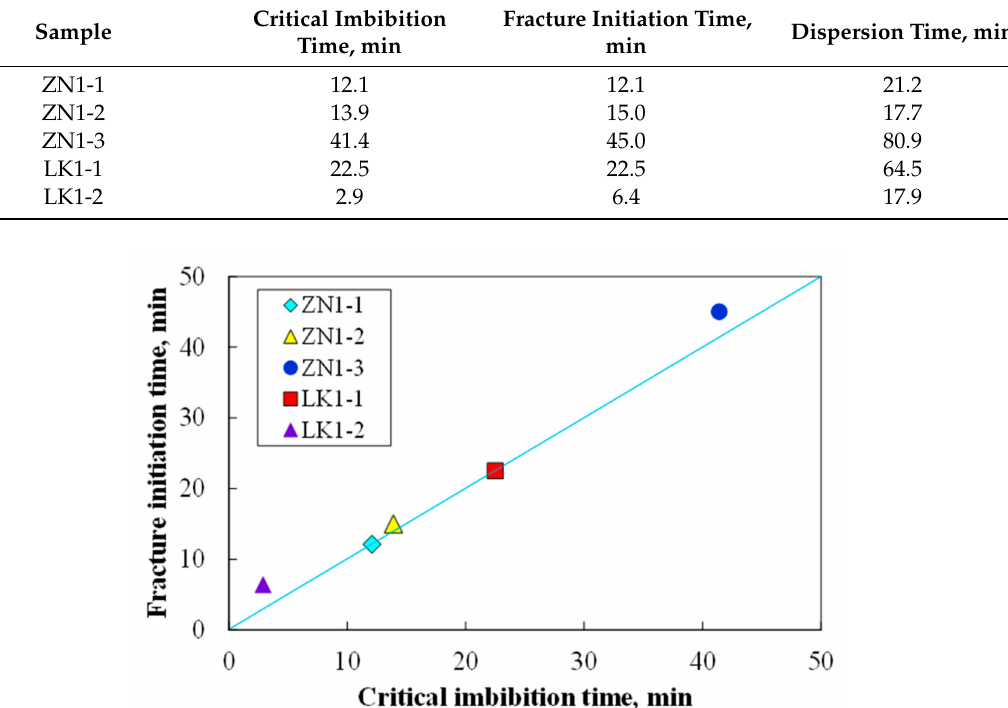
Table 4. Di ff erent characteristic imbibition time.